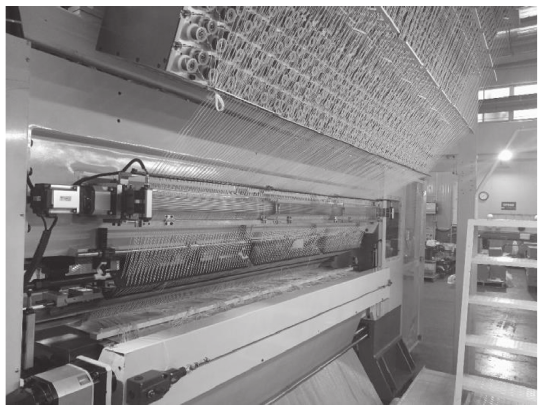
Figure 1: The carpet tufting